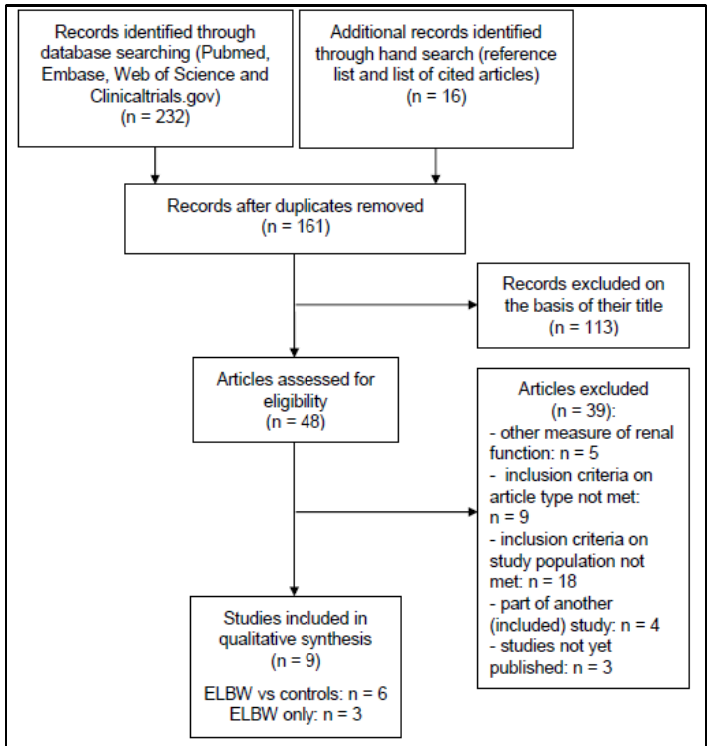
Figure 1. Preferred Reporting Items for Systematic Reviews and Meta-Analyses (PRISMA) flow chart describing the search strategy and results.